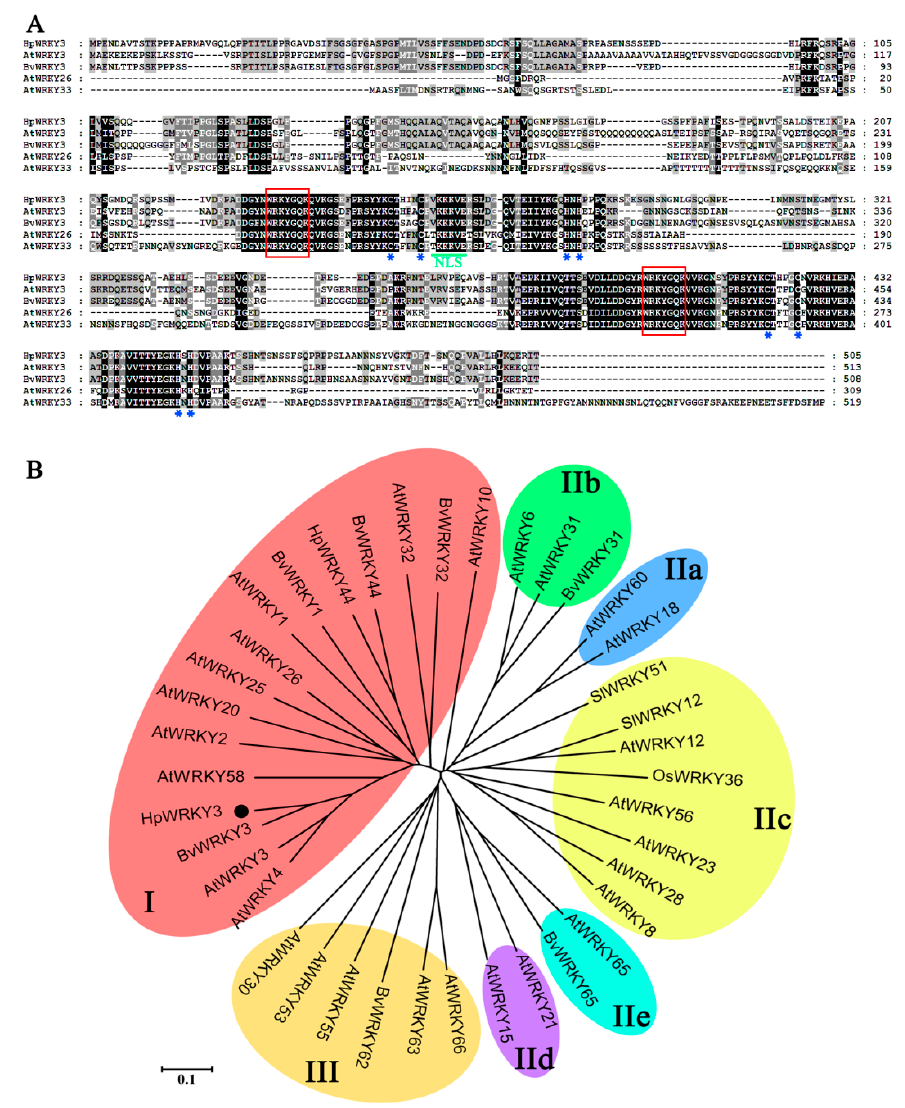
Figure 4. Multiple sequence alignment and phylogenetic analysis of HpWRKY3. ( A ) Multiple alignment of HpWRKY3 with other WRKY members. The following proteins were used for analysis: AtWRKY3 (NP_178433.1), BvWRKY3 (XP_010683088.1), AtWRKY26 (NP_196327.1), and AtWRKY33 (NP_181381.2). Identical and similar amino acids were shaded in black and grey, respectively. The WRKY domains and the zinc-finger structures are boxed and marked by asterisks, respectively. ( B ) Phylogenetic analysis of WRKYs. HpWRKY3 was highlighted with black circle. The phylogenetic tree was constructed with neighbor-joining test using MEGA program (version 5.0).